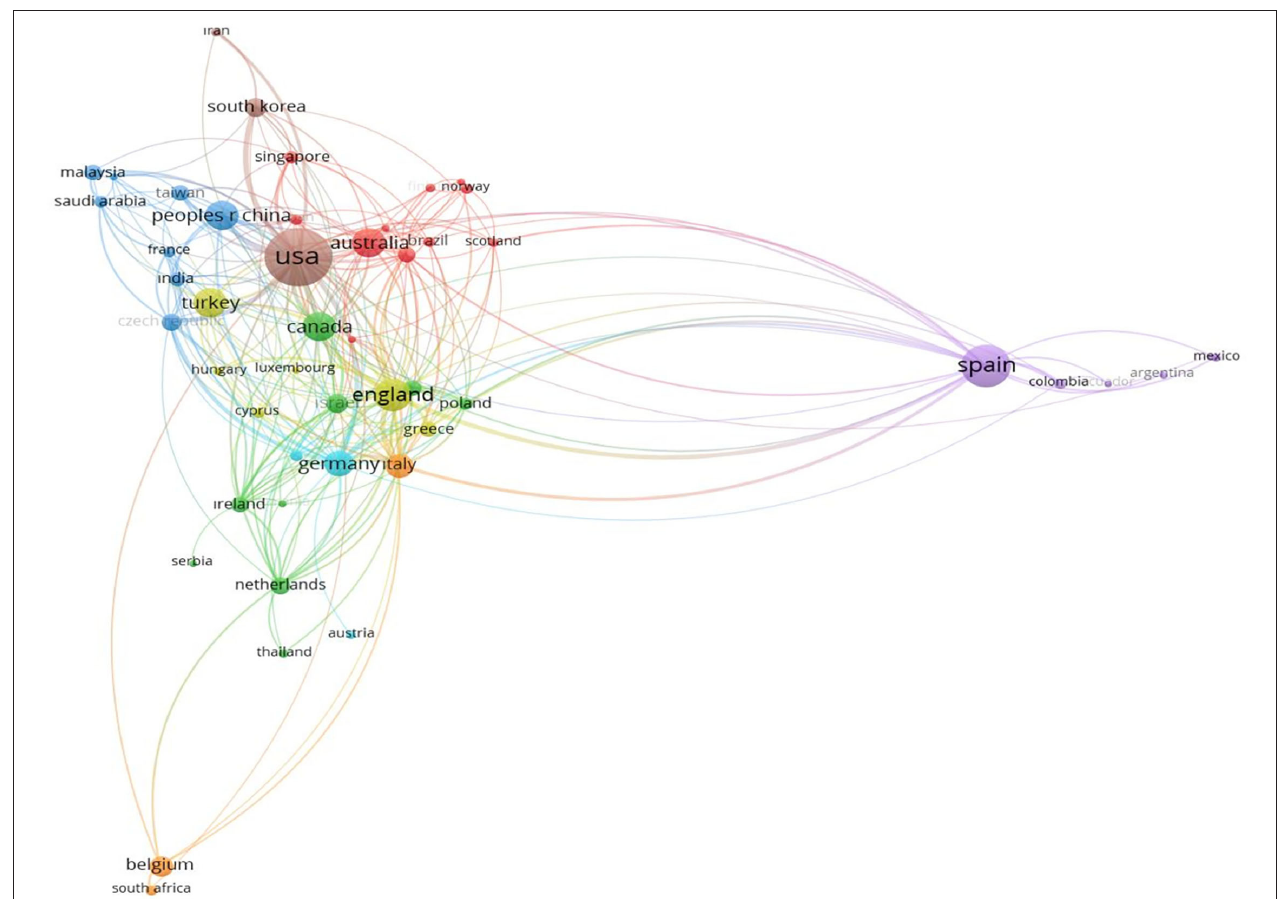
FIGURE 2 | Cooperation between countries.